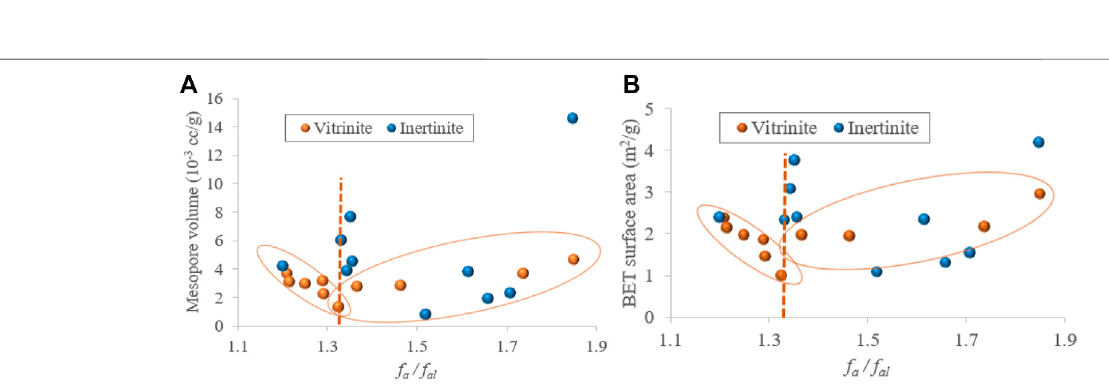
FIGURE 8 | Micropore volume and surface area of vitrinite (A) and inertinite (B) .